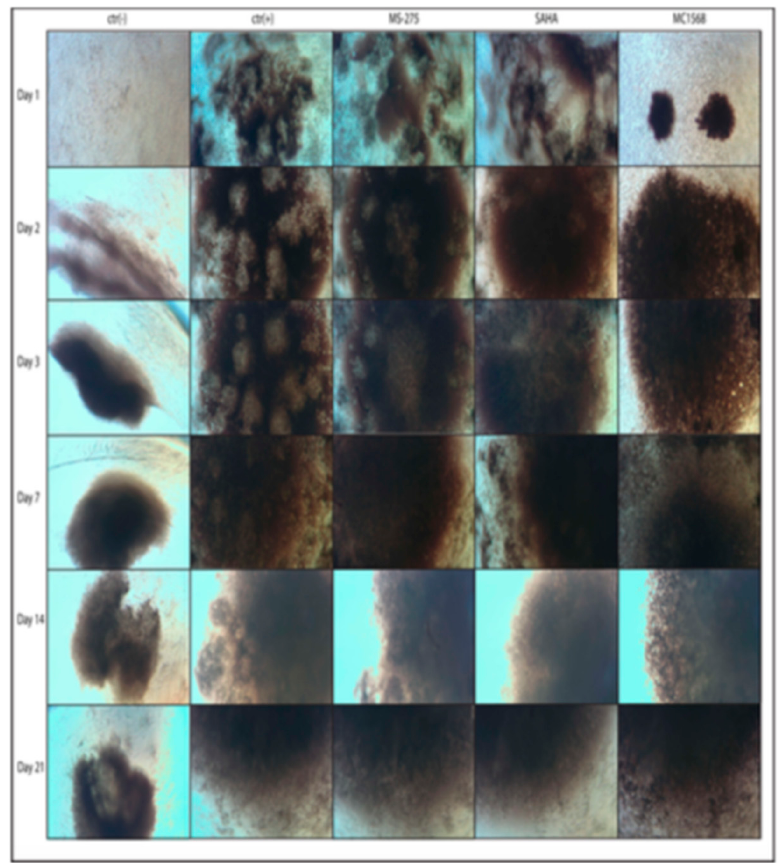
Figure 1. Photos taken 1, 2, 3, 7, 14, and 21 days after the inductions [ctr( − ), ctr(+), MS-275 , SAHA , and MC1568 ] of the three-dimensional structures (spheroid-like) that were formed by the condensation of high-concentration hMSCs (1 × 10 6 cells/200 µL) plated in 96 wells with a conical bottom.